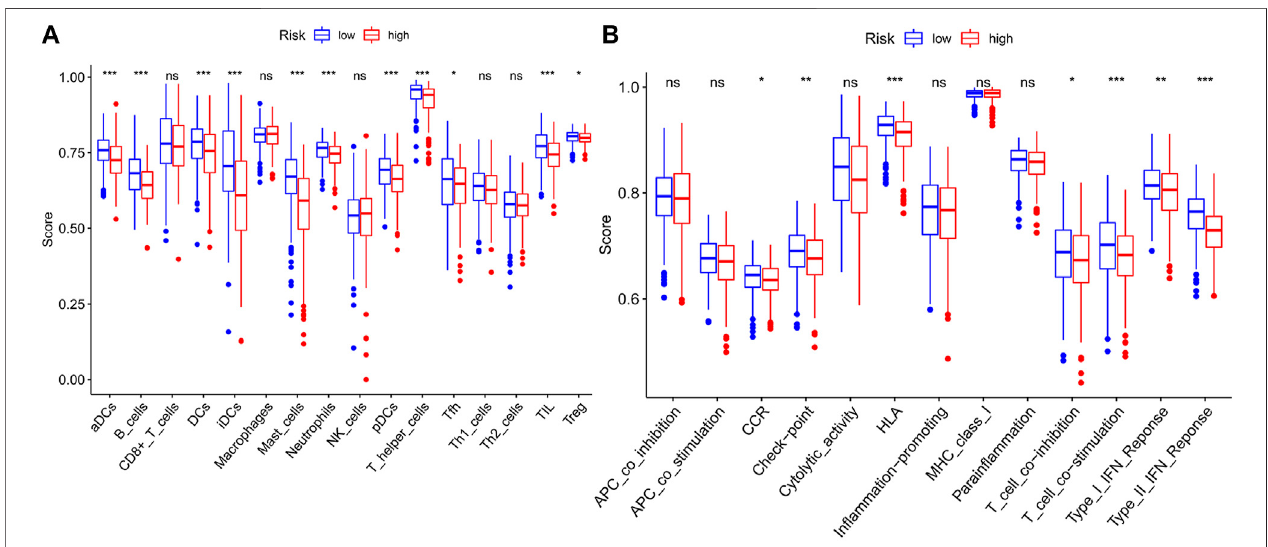
FIGURE 6 | The ssGSEA scores between two risk groups in the TCGA tumor cohort. The scores of 16 immune cells (A) and 13 immune-related functions (B) are displayed in boxplots. ssGSEA: single-sample gene set enrichment analysis. CCR: cytokine – cytokine receptor. ns, not signi fi cant; * p < 0.05; ** p < 0.01; *** p < 0.001.